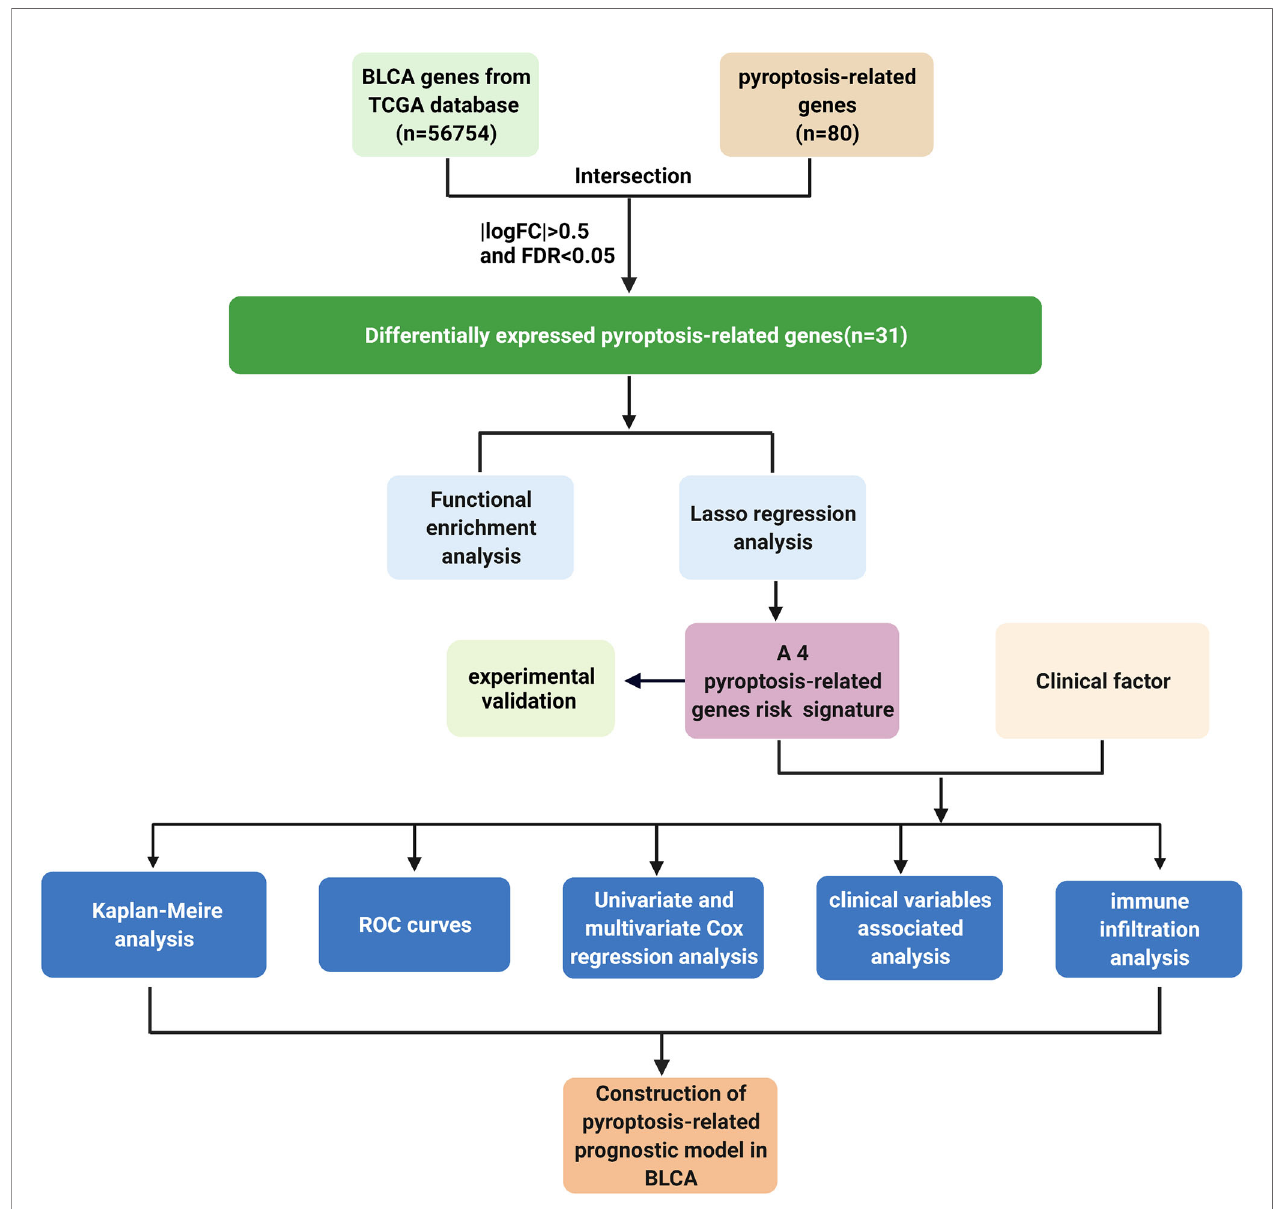
FIGURE 1 | Work fl ow chart. Detailed data analysis work fl ow chart. Create